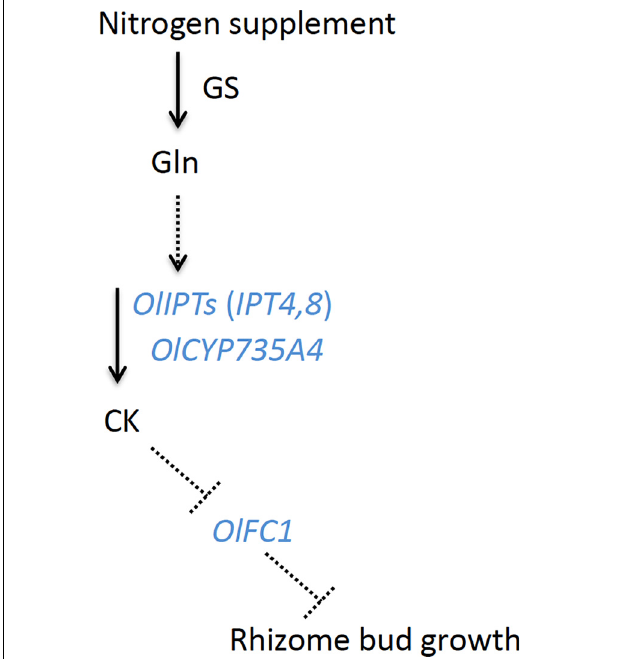
FIGURE 6 | A model of hormonal control of rhizome axillary bud outgrowth in O. longistaminata. In this model, the nitrogen supply induces the accumulation of glutamine. Subsequently, a glutamine-related signal activates the expression of cytokinin biosynthesis genes, including OlIPT4, OlIPT8, and OlCYP735A4 . The cytokinins negatively regulate the expression of OlFC1 , the product of which functions to repress the outgrowth of the rhizome axillary bud. GS, glutamine synthetase; CK, cytokinin. Solid arrows represent the metabolic flow. Dashed arrows and T-end lines represent positive and negative regulation,